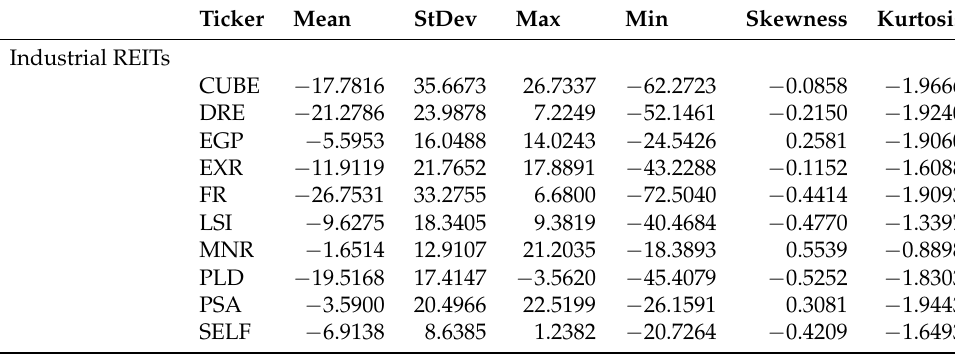
Table A4. Descriptive Statistics for Industrial and Retail REITs Quarterly Returns, the GFC Period. Ticker Mean StDev Max